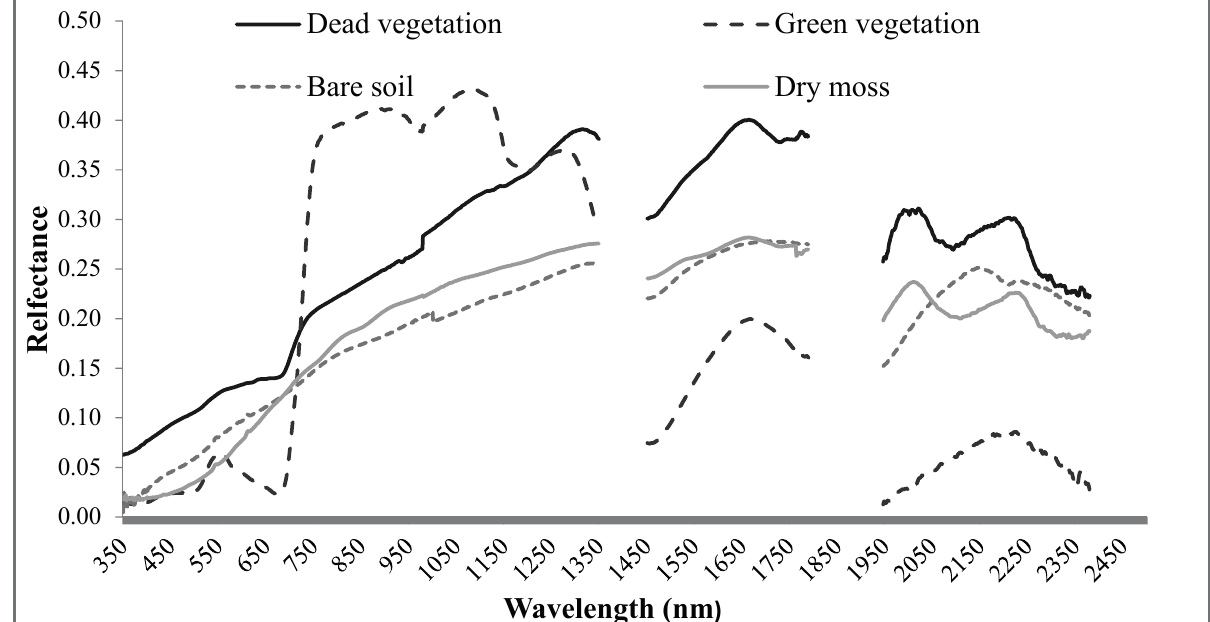
Figure 2. Spectral response curves of dead vegetation, green vegetation, bare soil, and dry moss as dominated BSC (samples were collected from Grasslands National Park, Canada and their spectra were measured in laboratory with an ASD